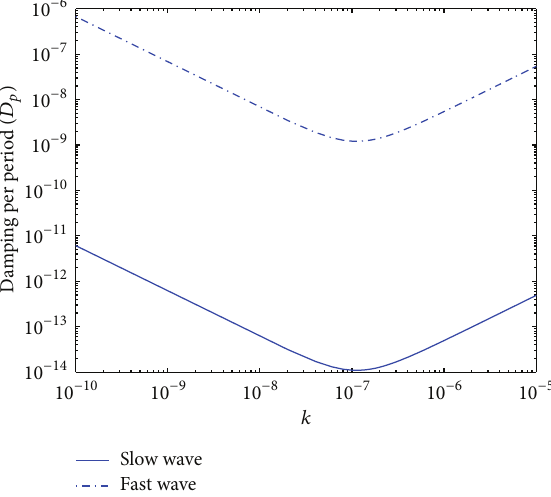
Figure 4: Damping per period 𝐷 𝑝 of fast waves versus wavenumber k .